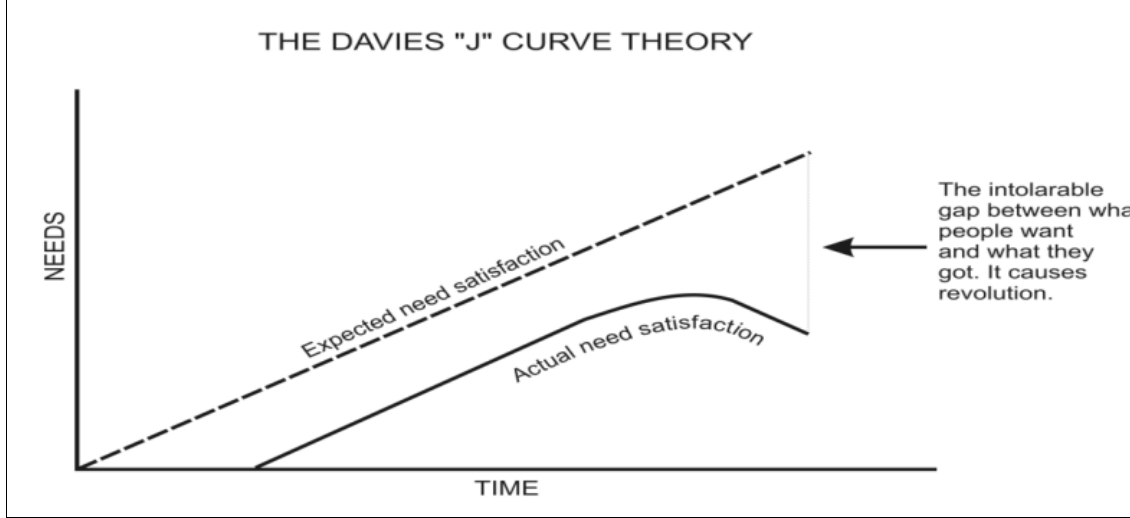
Figure 3: The deprivation hypothesis and scarcity. Source: Jackson and Jackson